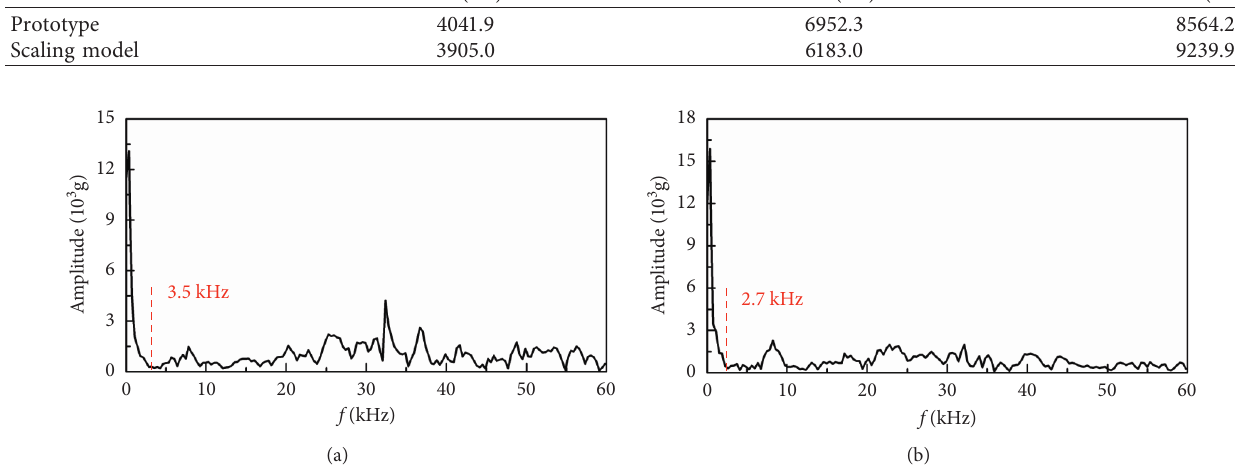
Table 5: First three orders of modal frequency of the prototype and scaling model projectile (including the deceleration measurement device).